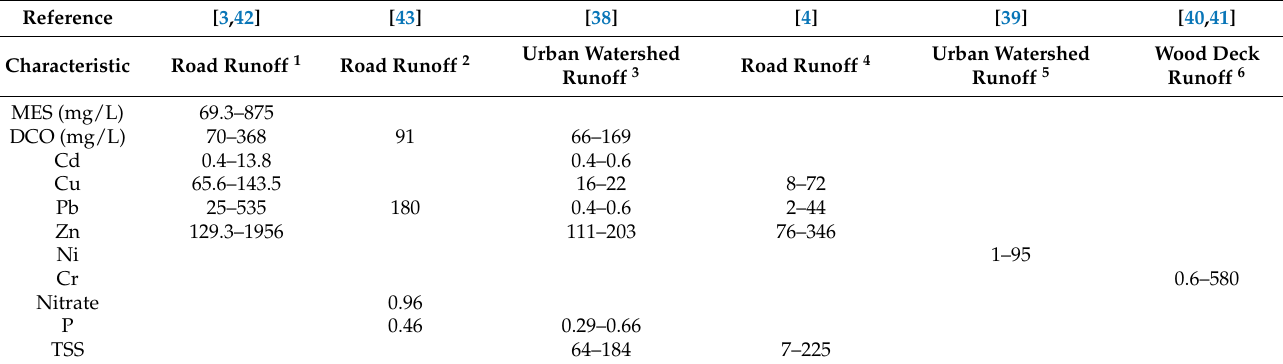
Table 4. Literature examples of runoff contaminant concentration